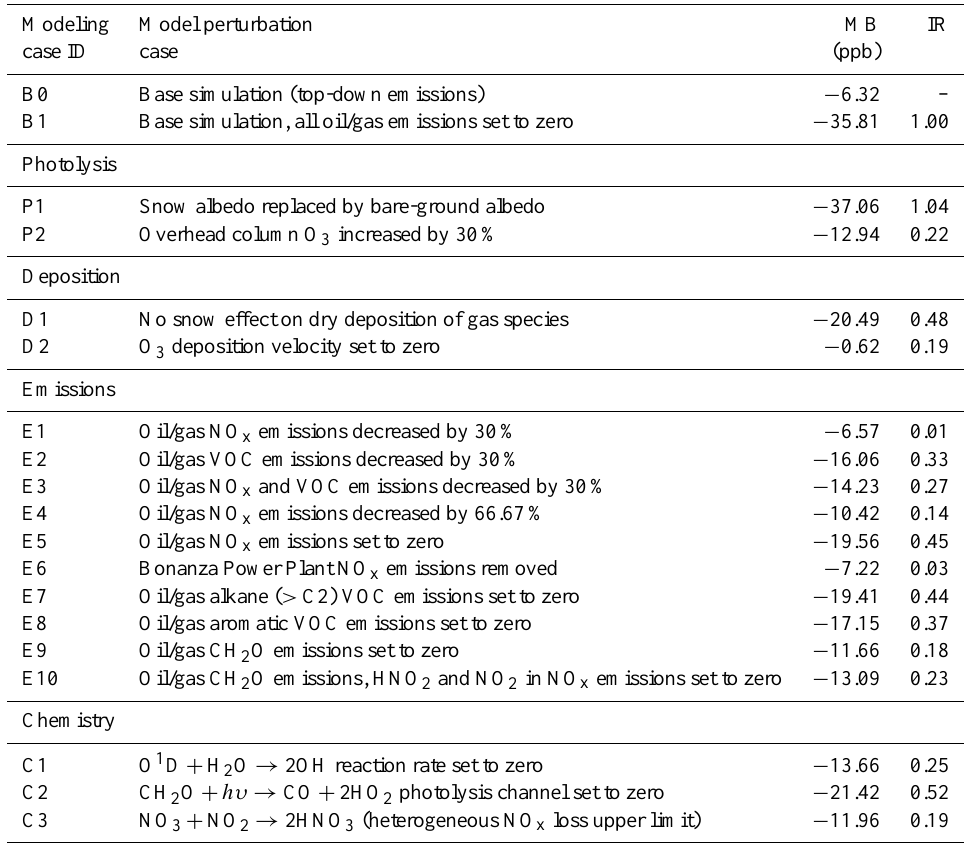
Table 4. Median bias (MB) and impact ratio (IR) for O 3 at Horse Pool for various perturbations to the base model. Model results are compared against hourly average observations between 09:00 and 17:00MST, 29 January–8 February